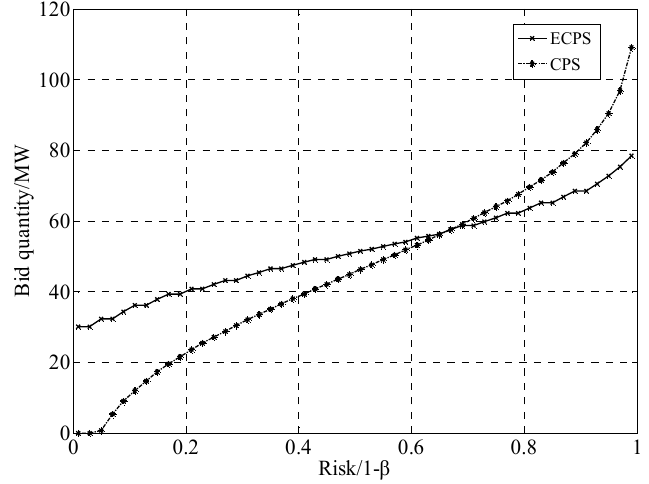
Figure 9. Comparison of bid quantity versus 1 − β between the CPS and